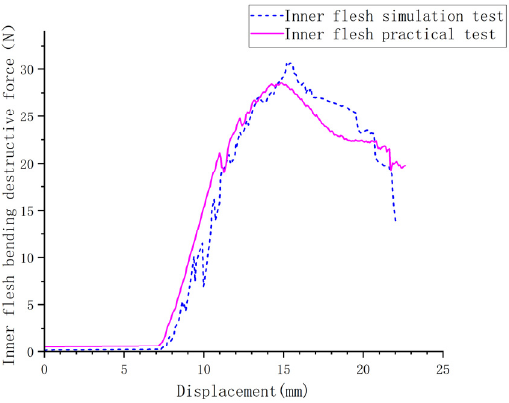
Figure 14. Comparison of the results of bending damage force in the inner flesh of straw.